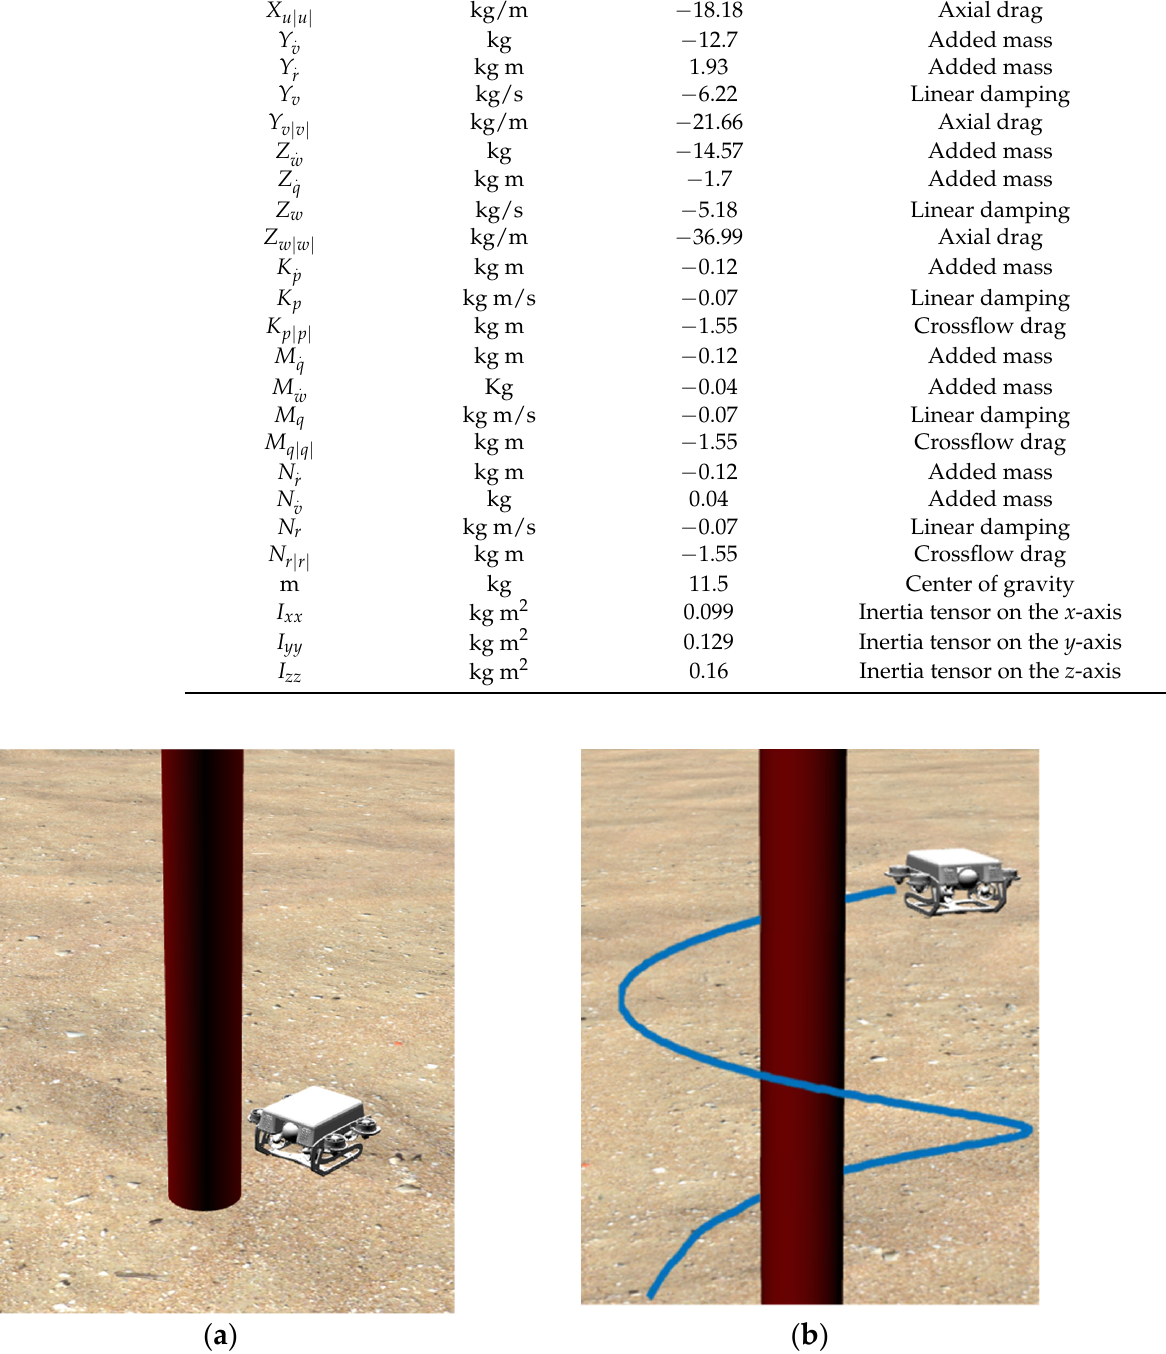
Figure 5. AUV in a simulated underwater environment. ( a ) Hover; ( b ) motion trail.